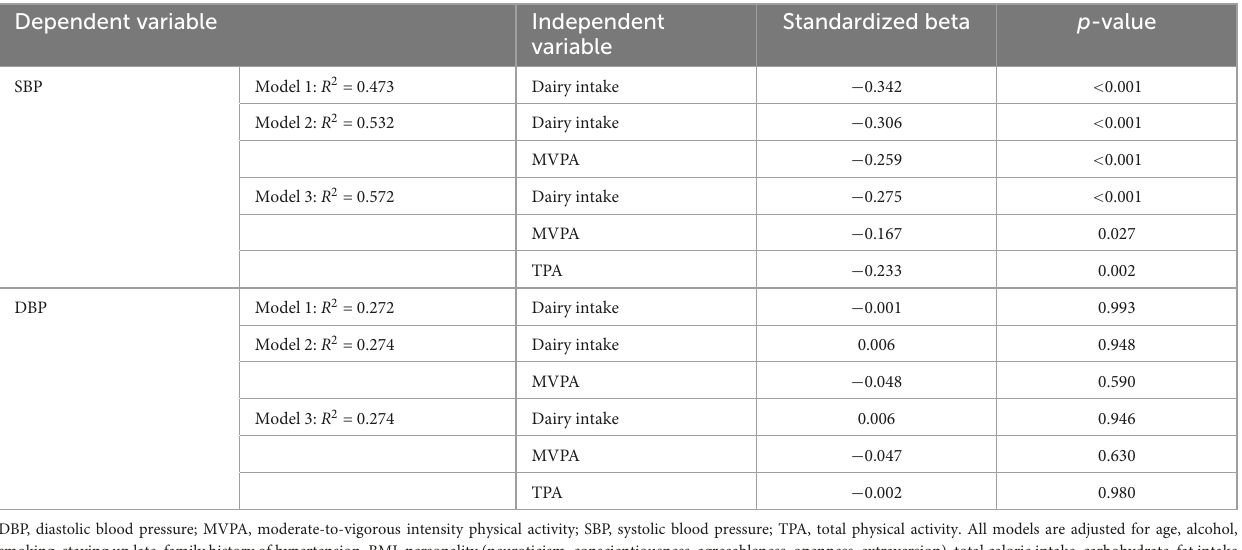
TABLE 5 Standardized regression coefficients of dairy intake, MVPA, and TPA for BP measures.